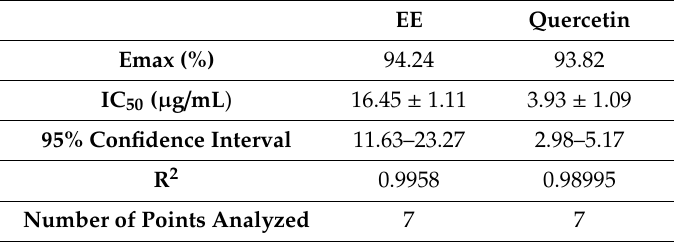
Table 2. DPPH radical scavenging activity of EE.